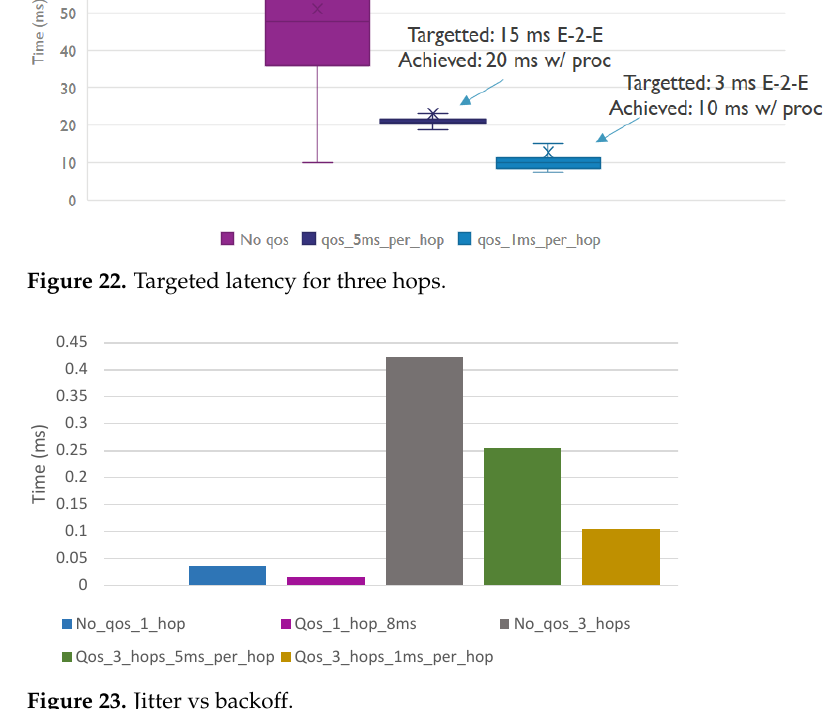
Figure 23. Jitter vs